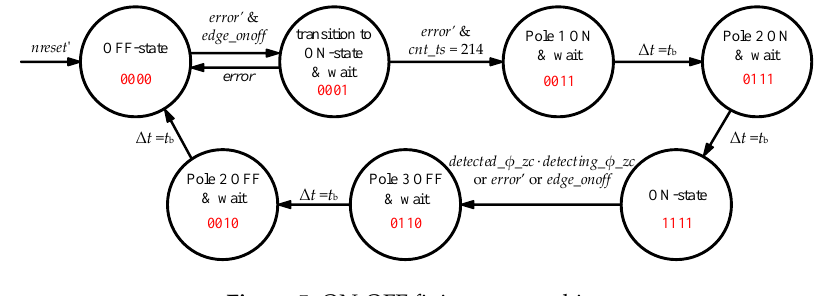
Figure 5. ON-OFF finite state machine.